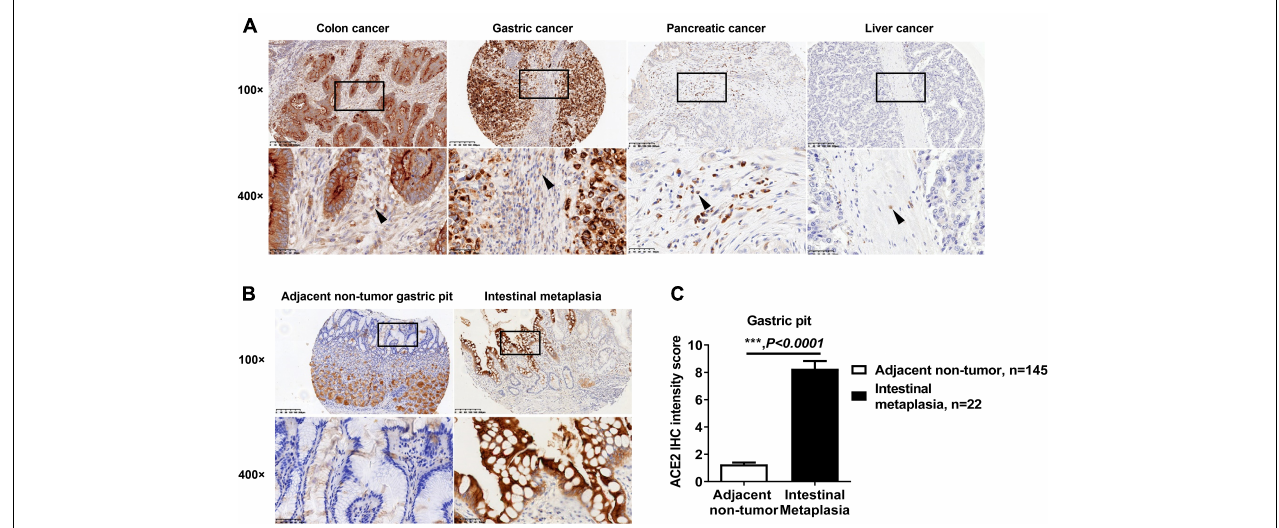
FIGURE 3 | Expression pattern of ACE2 in intestinal metaplasia and tumor mesenchymal tissue. (A) Representative IHC staining of human gastrointestinal tumor sections with anti-ACE2 antibody. The black boxes are the indicated 400 × fields in the 100 × sections, and the black arrow indicates mesenchymal cells. (B) Representative IHC staining of human gastric pit sections with anti-ACE2 antibody. The black boxes are the indicated 400 × fields in the 100 × sections. (C) Comparison of the ACE2 IHC intensity score between intestinal metaplasia and gastric pit cells. Scale bar, 200 µ m (100 × ) and 50 µ m (400 × ). Data are shown as the mean ± SEM.